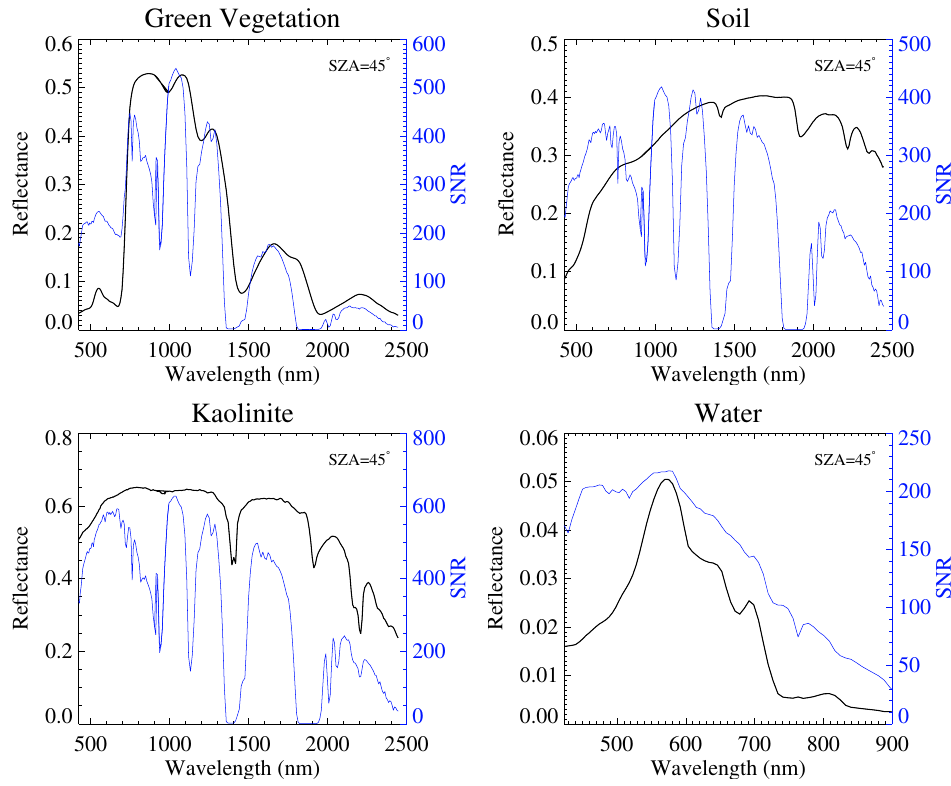
Figure 5. Simulated spectral signal-to-noise ratio (SNR) for incoming radiance levels corresponding to a Sun zenith angle (SZA) of 45 ◦ and surface reflectance spectra representing different EnMAP application